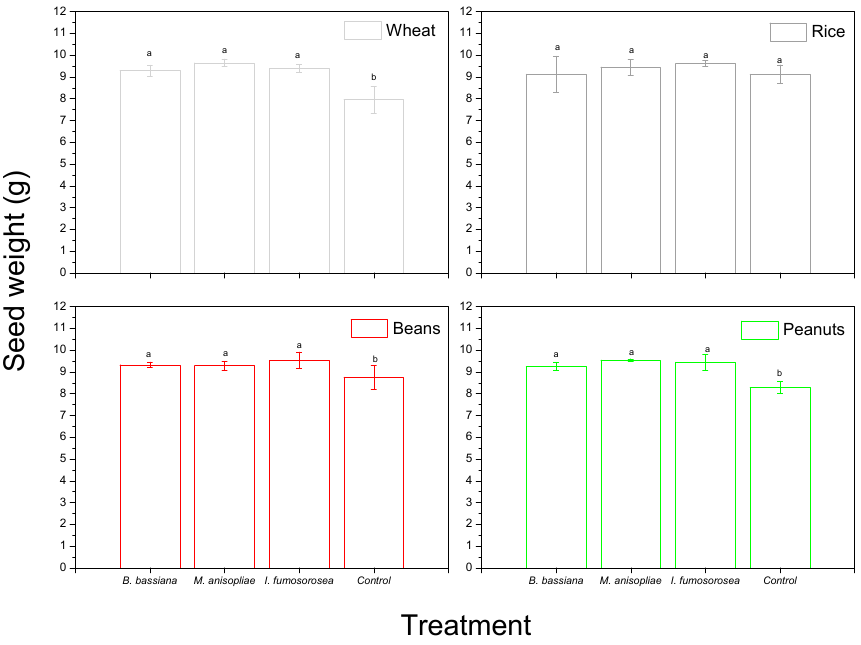
Figure 4. Seed weight (g ± SD) of wheat, rice, beans and peanuts treated with 10 8 spores mL − 1 of B. bassiana (strain name: GBBSTTS), I. fumosorosea (strain name: RHZ4RAS) and M. anisopliae (strain name: Z3RAS), after infestation with T. confusum larvae for 10 days.